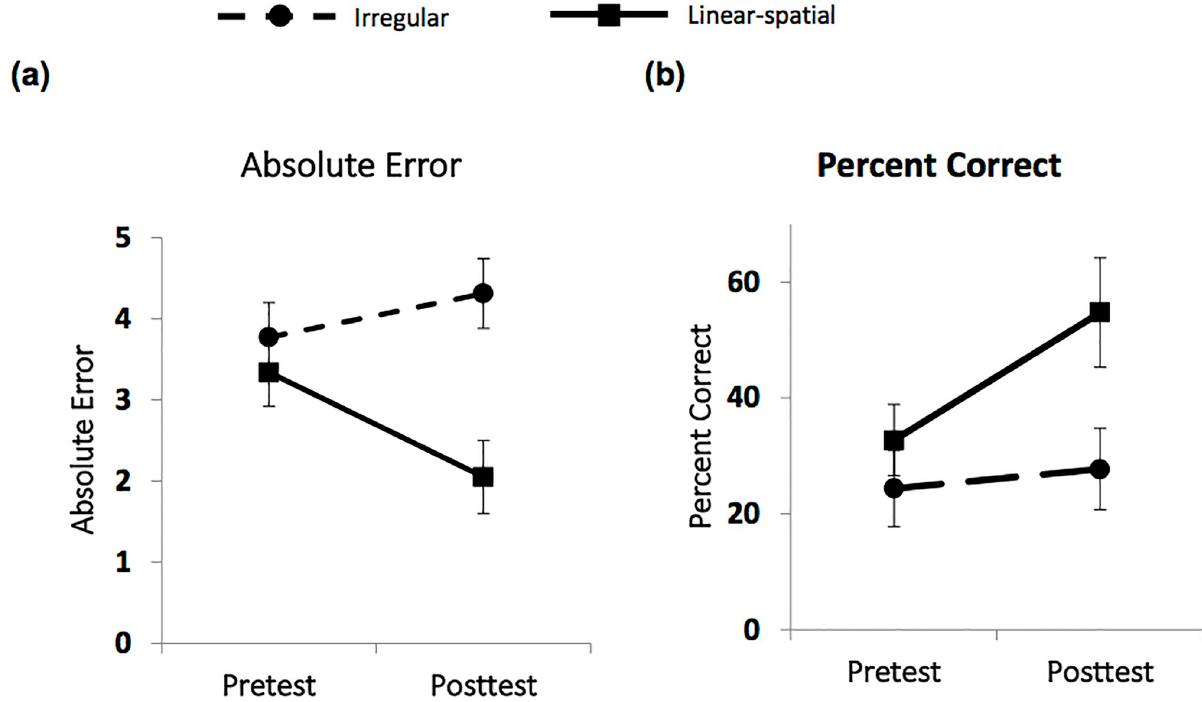
Fig 2. Pretest to posttest improvement in (a) absolute error and (b) percent correct on addition problems for children who practiced with irregular versus linear-spatial materials.